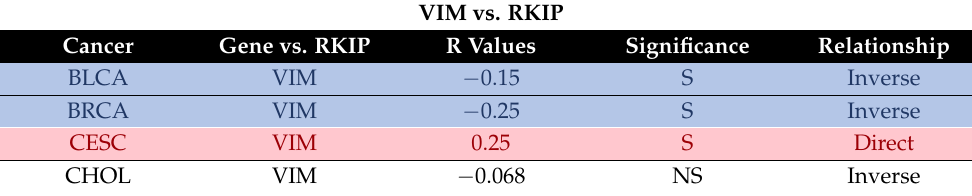
Blue: Significant Inverse Relationship; Red: Significant Direct Relationship. Table 2. RKIP vs. VIM. A bioinformatic analysis was performed across 23 different cancer types comparing the presence of RKIP against VIM. From this data, a p -value and an R value were determined for each of the cancer types. The table above organized the bioinformatic data. For each cancer type, the R value was reported in the third column. Significance was determined based on the p -value, with a p -value less than 0.05 indicating a significant value. The relationship between RKIP and VIM was determined through the sign of the R value. A negative R value indicated an inverse relationship while a positive R value indicated a direct relationship. The rows highlighted in blue indicate a significant, inverse relationship between RKIP and VIM. The rows highlighted in red indicate a significant, direct relationship between RKIP and